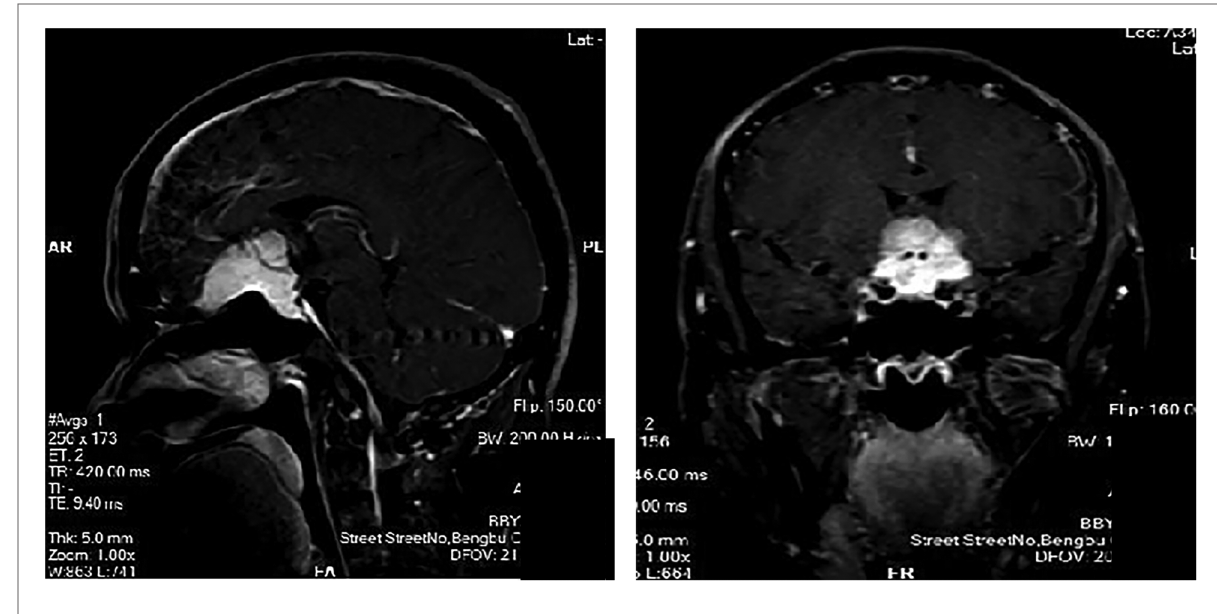
FIGURE 5 The tumor completely surrounded bilateral anterior cerebral